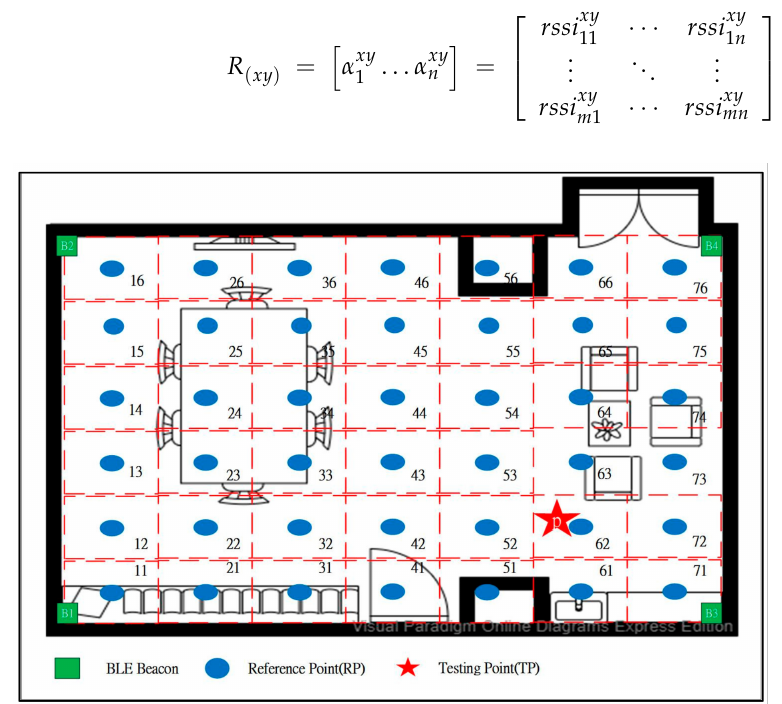
Figure 6. Bluetooth low energy beacon deployment context